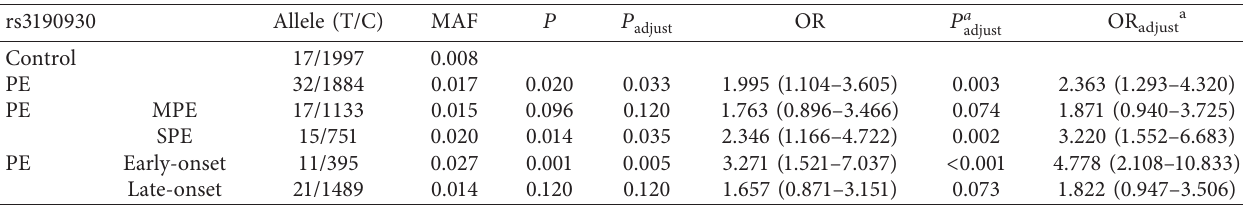
Table 3: Allele frequencies of PTPRK rs3190930 in women with and without